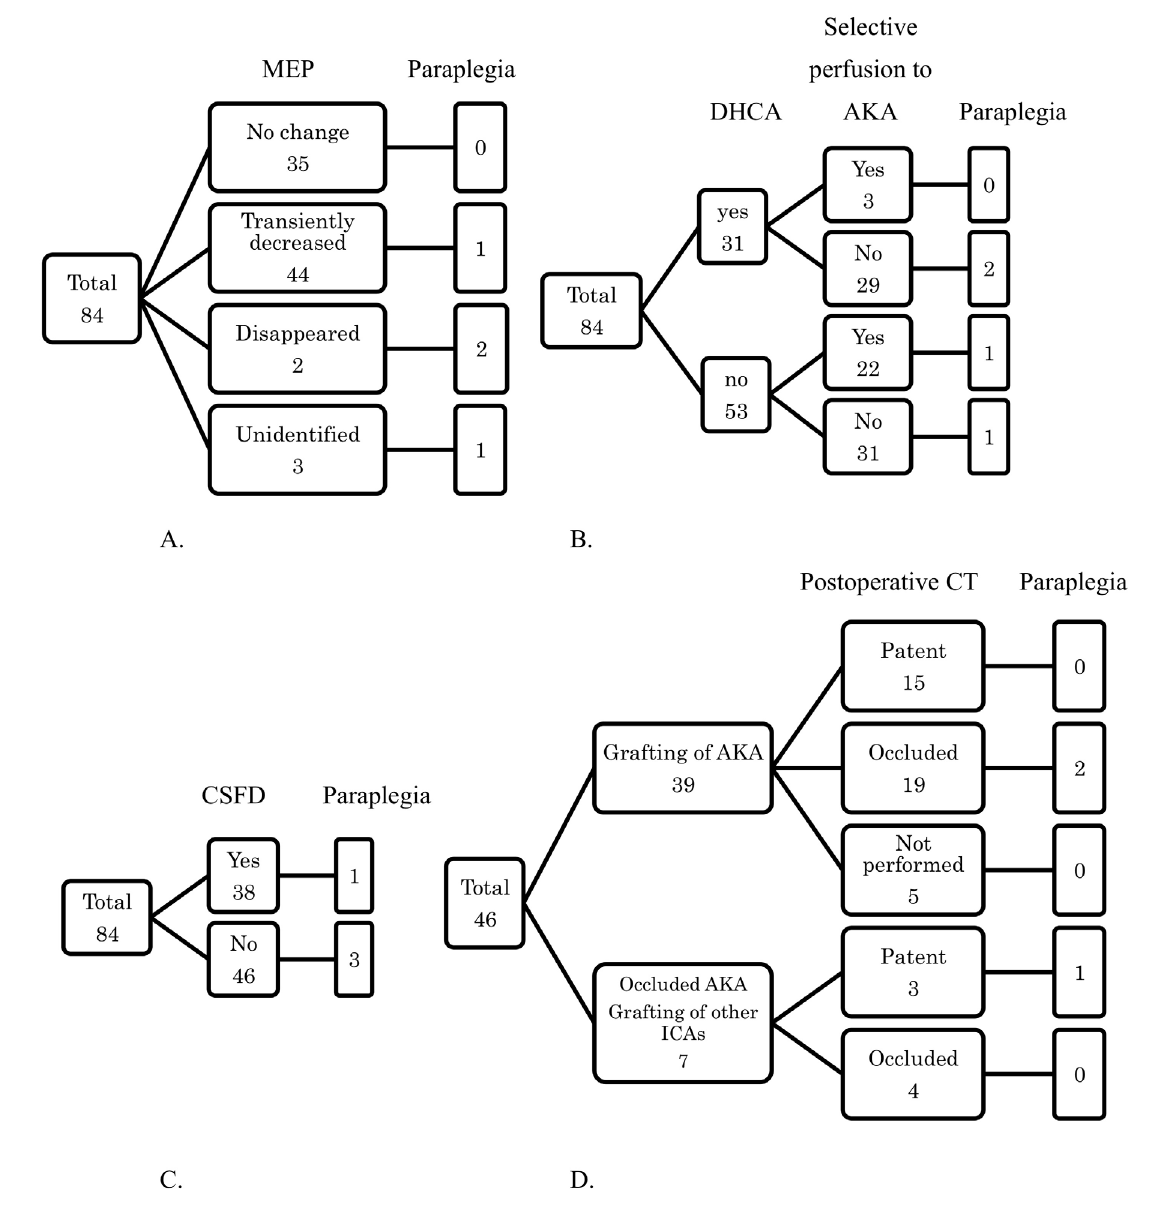
Fig. 2 - Relations between paraplegia and spinal cord protection measures. A) Changes in motor evoked potential (MEP) during operation; B) use of deep hypothermic circulatory arrest (DHCA) and selective perfusion to Adamkiewicz artery (AKA); C) use of cerebrospinal fluid drainage (CSFD); D) intercostal artery (ICA) reconstruction. CT=computed